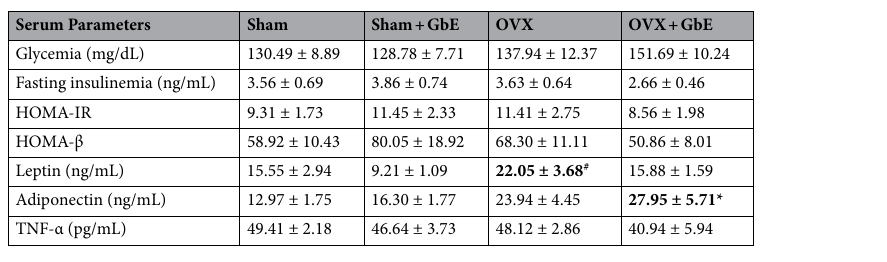
Table 1. Serum parameters of Sham, Sham + GbE, OVX and OVX + GbE. Serum parameters of Sham (n = 10–14), Sham + GbE (n = 11–16), OVX (n = 10–14) and OVX + GbE (n = 10–15) groups. * p ≤ 0.05 vs. Sham; # p ≤ 0.05 vs. Sham + GbE; & p ≤ 0.05 vs. OVX.